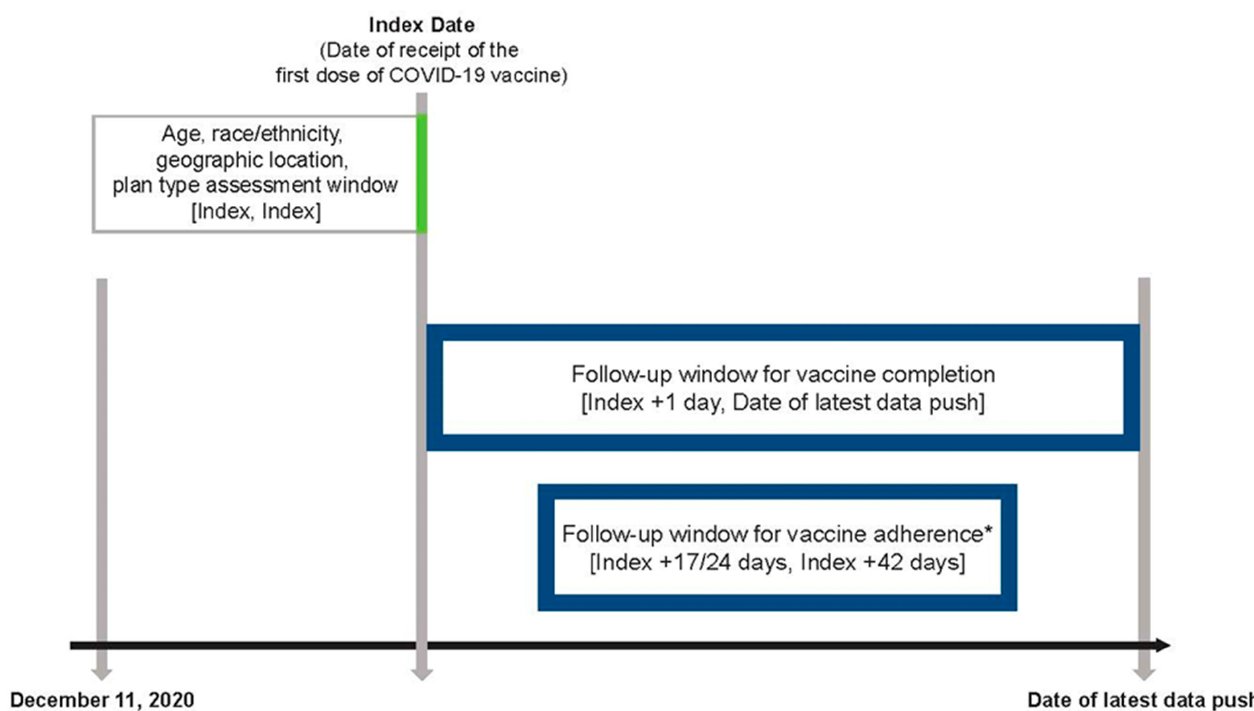
Figure 1. The study design. * Assessment period for adherence was determined based on FDA-approved dosing schedule and CDC guidance at the time of the study. COVID-19, coronavirus disease 2019; CDC, Centers for Disease Control and Prevention; FDA, US Food and Drug Administration.